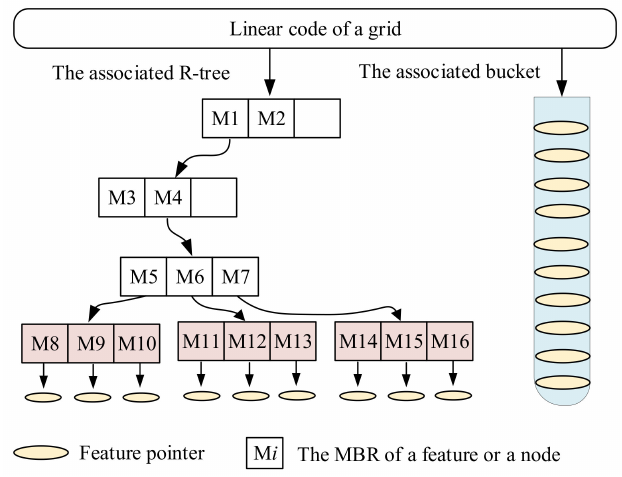
Figure 4. Data structure of the QRB-tree index.